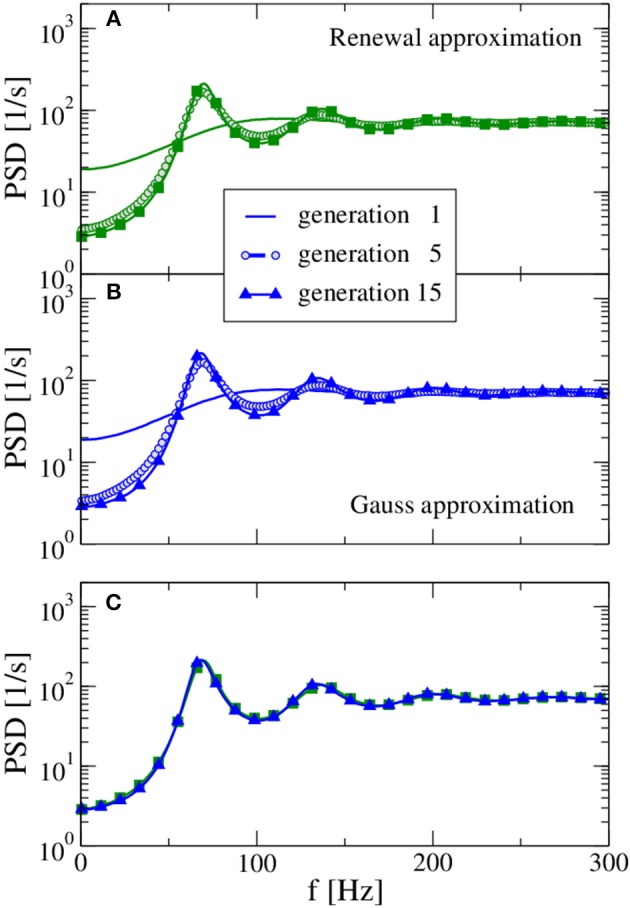
Power spectra resulting from the self-consistent procedure. For balanced input from the previous generation (g = 4) and a large presynaptic environment (CE = 103, CI = 250) both the renewal approximation (A) and the Gaussian approximation (B) have converged to unique stationary spectra, which are compared in (C). In the first generation, the neuron is stimulated by a constant input 〈RI(t)〉 = 30 mV and CE + CI Poissonian spike trains of rate νin = 71 Hz [solution for the self-consistent firing rate Equation (13)] with amplitude J = 0.1 mV (excitatory synapses) and −gJ = −0.4 mV (inhibitory synapses). Note the rapid convergence of spectra for both approximations: the spectrum of the fifth generation differs only slightly from the result for the 15th generation.